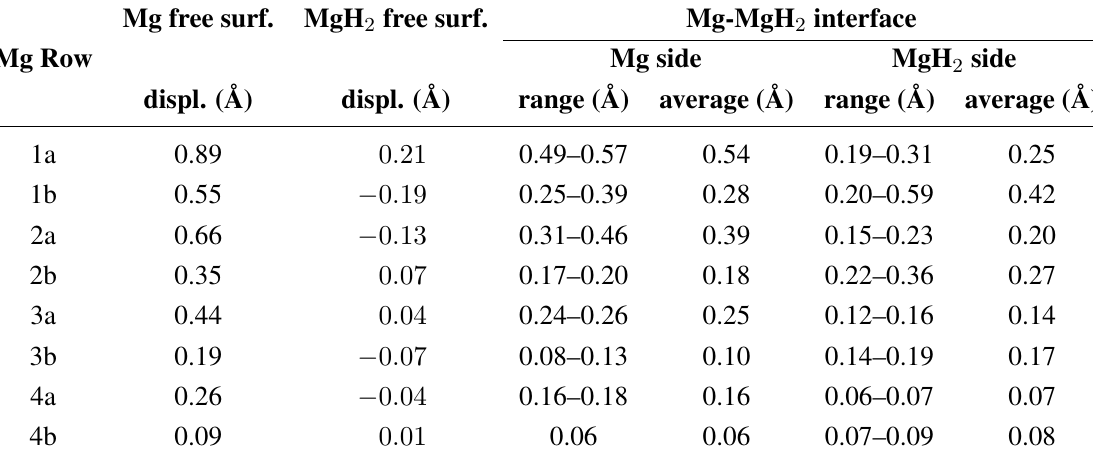
Table 1. Displacements in ˚A of Mg atoms after ionic relaxations with respect to initial positions, for magnesium free surface, magnesium hydride free surface and, Mg–MgH interface. For the free surfaces all the atoms belonging to the same row move together, for the Mg–MgH interface we indicated the range and the average of 2